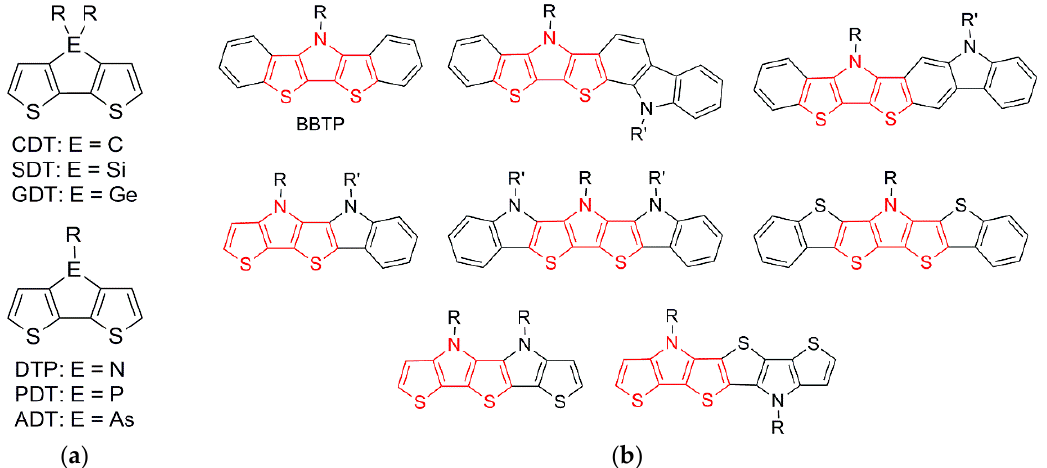
Figure 1. ( a ) Fused 2,2 ′‐ bithiophene building blocks; ( b ) Various extended fused ‐ ring analogues of dithieno[3,2 ‐ b :2 ′ ,3 ′‐ d ]pyrrole (DTP).